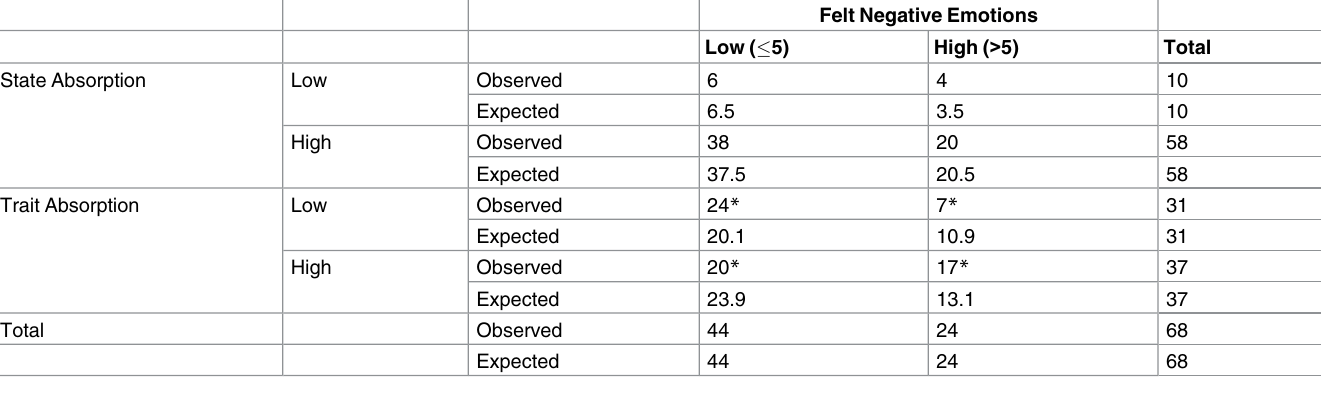
we performed a median split of the trait and of the state absorption scores and ran chi-square tests of each against high and low negative felt emotions. The cross tabulation results for state and trait absorption against high versus low negative felt emotions are shown in Table 2. Expected counts reflect the counts that are expected if responses are distributed equally for Table 2. The association of trait and state absorption with highly loved